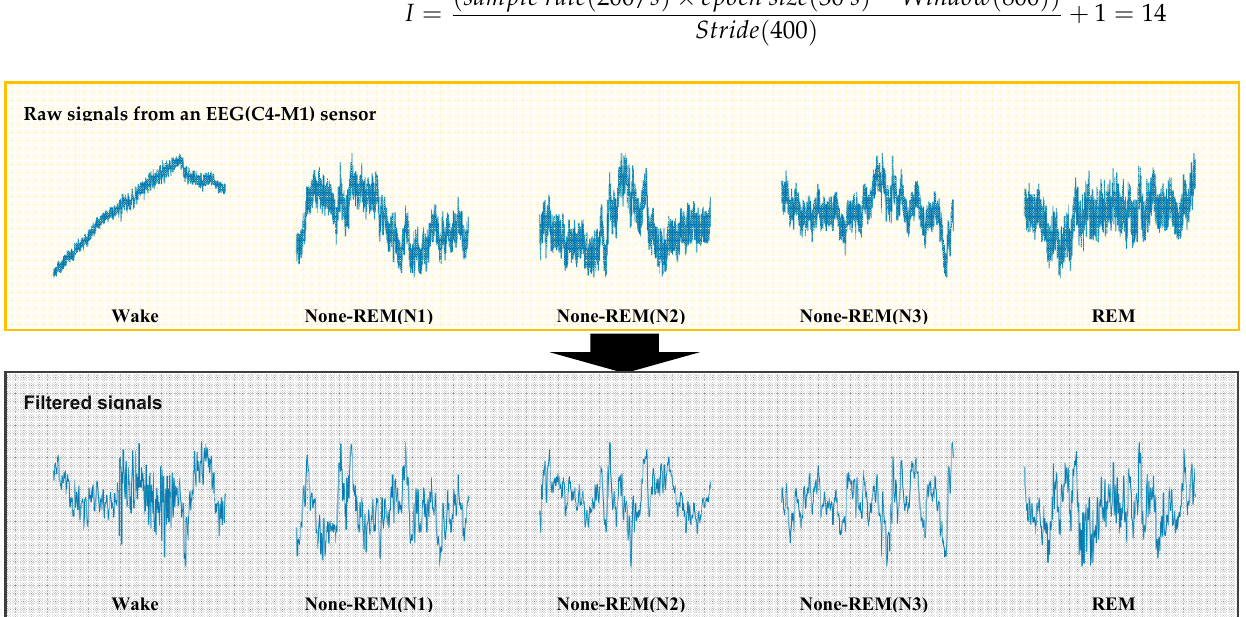
Figure 1. Representative raw data sample from each sleep stage. Bandpass filtering was applied to raw polysomnographic data to reduce impact of noise and for artifact reduction.